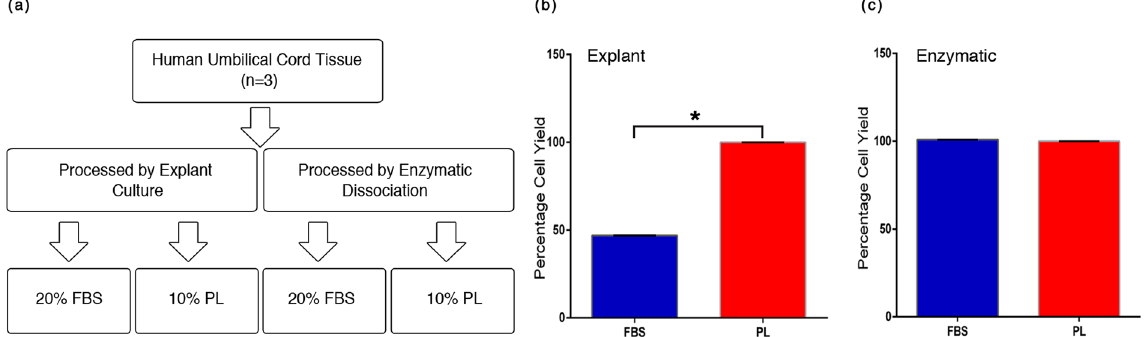
Figure 2. Umbilical cord tissue processing and MSC yield. ( a ) A schematic representation for isolation of MSC from hUCT using explant and enzymatic dissociation culture employing 20% FBS and 10% PL supplemented medium. ( b ) Comparison of percentage of viable cell yields from explant and ( c ) enzymatically dissociated cultures supplemented with 20% FBS and 10% PL using trypan blue dye exclusion. Results are expressed as mean ± SEM of three processed samples. Paired one tailed student’s t test for explant cultures and enzymatic cultures were P = 0.03 and P = 0.49 respectively. * P < 0.05.